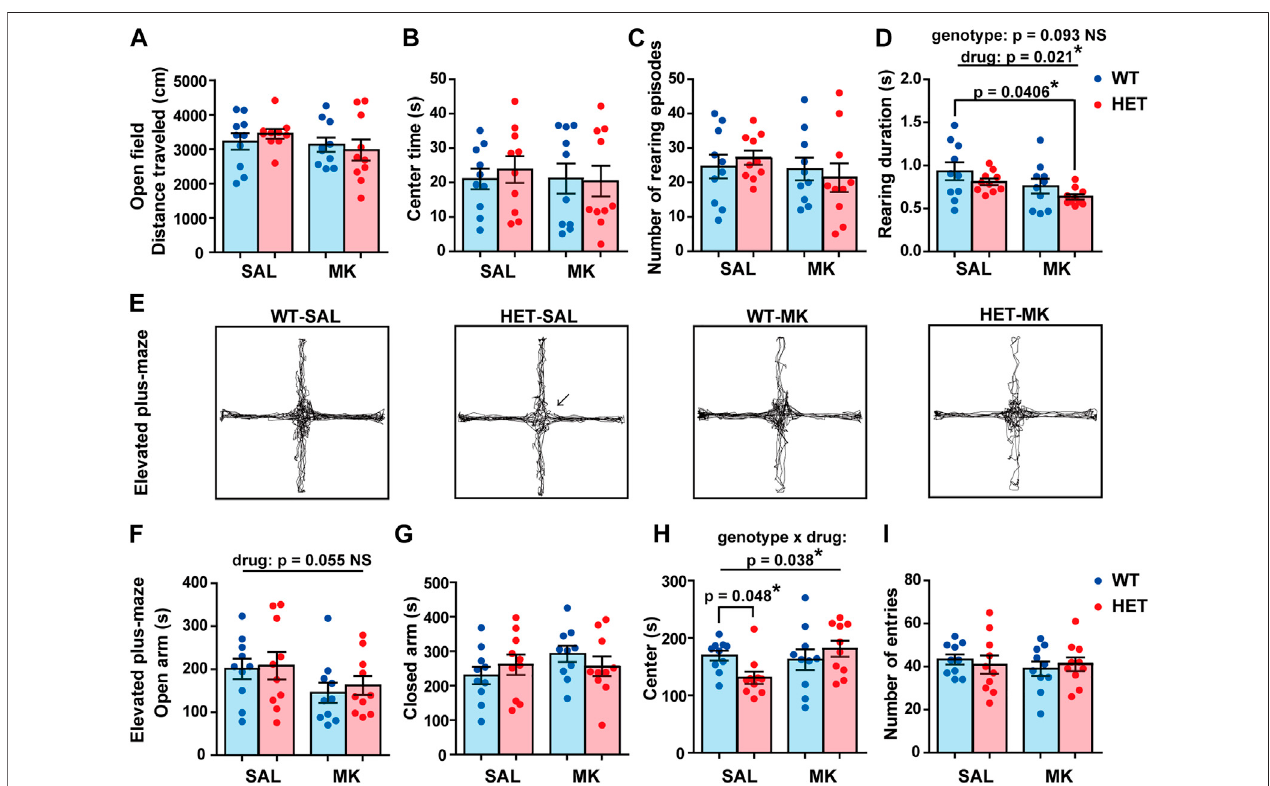
FIGURE 1 | Exploratory and anxiety-like behaviors were in fl uenced by Gad1 genotype and MK-801 treatment. In the open fi eld test, (A) the distance traveled, (B) exploration time of the center region, and the number of rearing episodes were comparable between the four groups. The rearing duration for each episode was signi fi cantly reduced by MK-801 treatment ( p (cid:2) 0.021). The effect of genotype on the rearing duration was a subthreshold level ( p (cid:2) 0.093). However, as a result of the combination of these two effects, the HET-MK group showed a signi fi cantly shorter duration than that of the WT-SAL (Dunnett ’ s test; p (cid:2) 0.0406). (E) Representative trajectories in theelevatedplus-mazetest. The vertical arms wereopen whilethehorizontal arms were closed respectively. HET-SAL groups stayedless time in the center area of the maze (arrow). (F) The time spent on the open arms was not signi fi cantly different among the four groups, but a subthreshold level effect of MK-801 was observed ( p (cid:2) 0.055). (G) The time spent on the closed arm was not signi fi cantly different between the groups. (H) A signi fi cant effect of genotype × drug interaction wasobserved inthe time spent in the center area. The center time wasreduced in HET rats only in the SAL-treated condition. (I) The number ofentries to the arms was similar in the four groups. The results are presented as average ± SEM. Data were analyzed using two-way ANOVA. If a signi fi cant interaction of gene × drug wasobserved, a posthoc simplemaineffect testwasperformed(Bonferroniadjusted).Ifsigni fi cantorsubthresholdeffectswereobservedbothingenotypeand drug,a Dunnett ’ s test was carried out to assess the additive effect. WT: wild-type, HET: Gad1 +/ − , SAL: saline, MK: MK-801. * p < 0.05, ** p < 0.01; NS, not signi fi